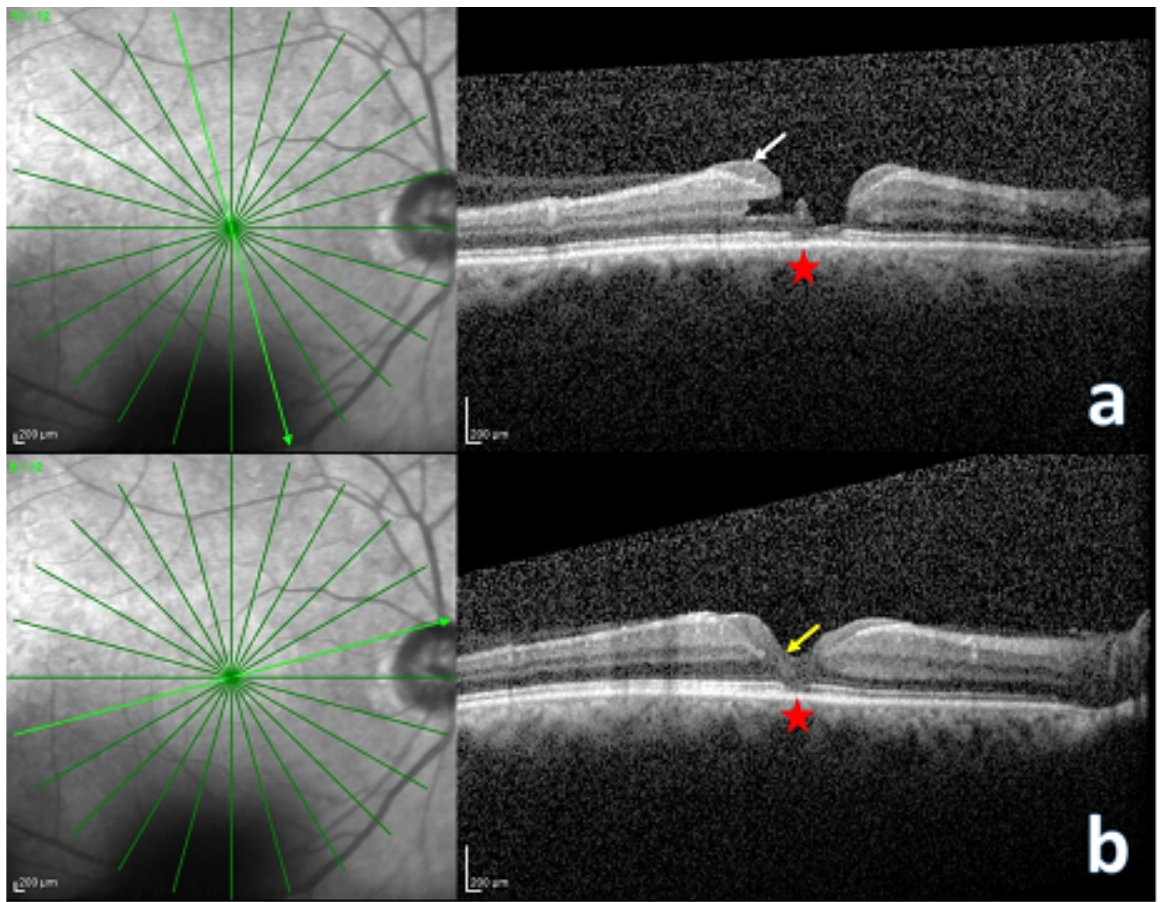
Figure 1. Lamellar macular hole (LMH) with EMPF. (a) Optical coherence tomography (OCT) image of a patient with LMH in right eye showing the presence of epiretinal proliferative tissue at the margin of the hole (white arrow) with presence of ellipsoid zone defect (red star). (b) Another OCT scan passing through a different section acquired on the same day demonstrating the extension of the proliferative tissue (yellow arrow) from the ellipsoid zone defect (red star) and then crawling along the walls of the macular hole to lie over the retinal surface.